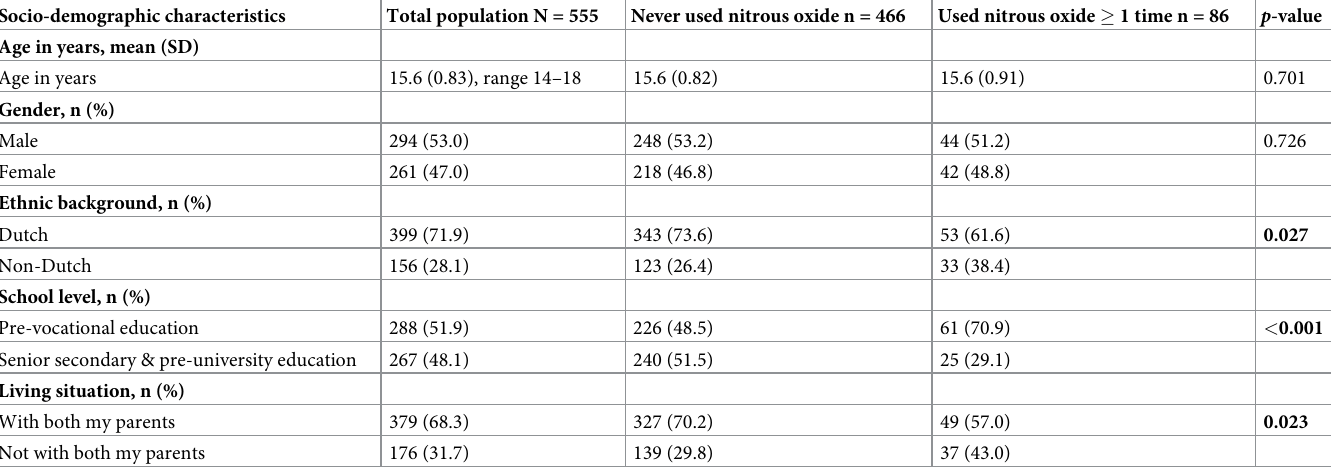
Table 1. Socio-demographic characteristics of the study population (N = 555).